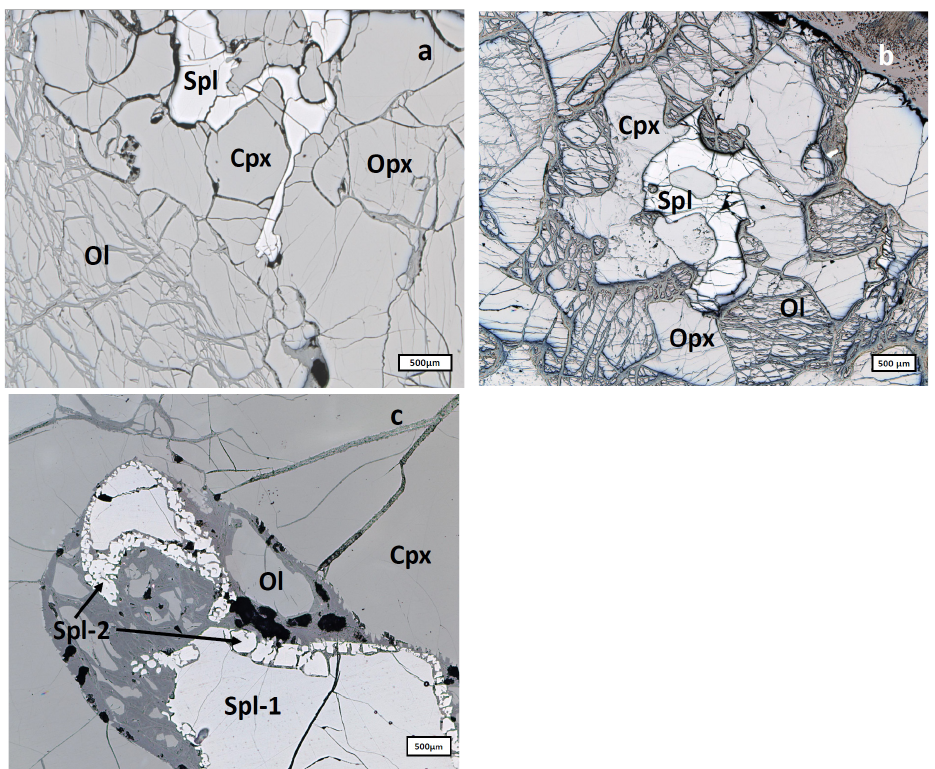
Figure 4. Types of spinels from Cpx-rich Spl lherzolites: ( a ), Primary spinel (Spl) represented by clean homogeneous grains of irregular shape; ( b ), Primary low-Cr spinel (Spl) from the sample XLT-5; initial stages of generation of spongy rim around clinopyroxene (Cpx) can be seen (see [4]); ( c ), Primary spinel grains (Spl-1) surrounded by the thin sporadic rim of secondary spinel (Spl-2). Ol, olivine.